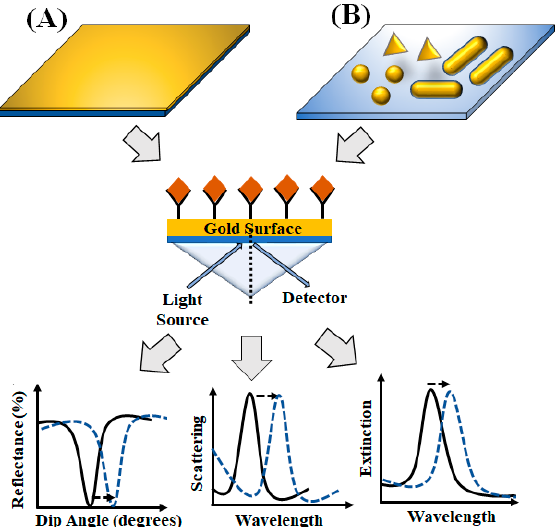
Figure 4. Representation of plasmon-based sensors and the different detection methods: ( A ) planar Representation of plasmon-based sensors and the di ff erent detection methods: metallic thin-film-based biosensors and ( B ) localized surface plasmon resonance (LSPR)-based ( A ) planar metallic thin-film-based biosensors and ( B ) localized surface plasmon biosensors.